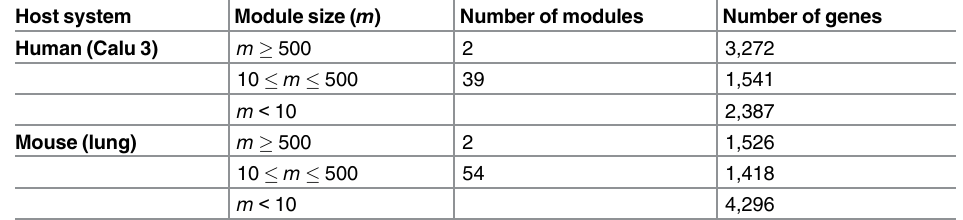
Table 1. Catalog of MERLIN modules for human and mouse systems.